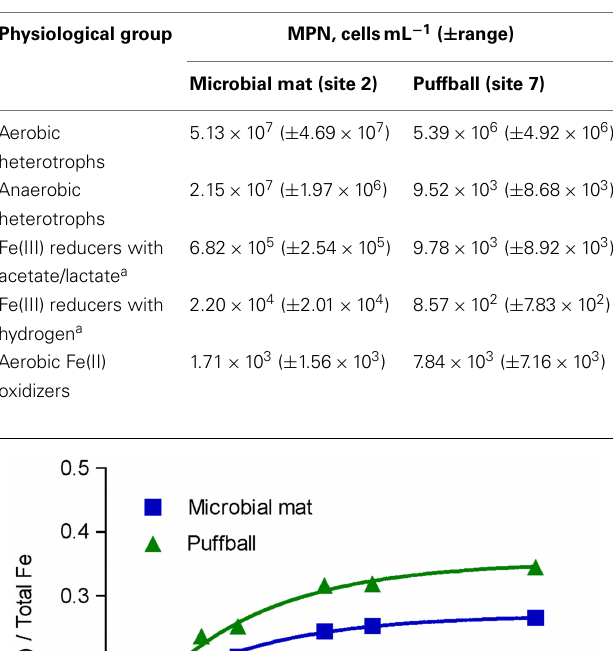
Table 2 | Most probable number values for different types of microorganisms in materials from the microbial mat and puffball.